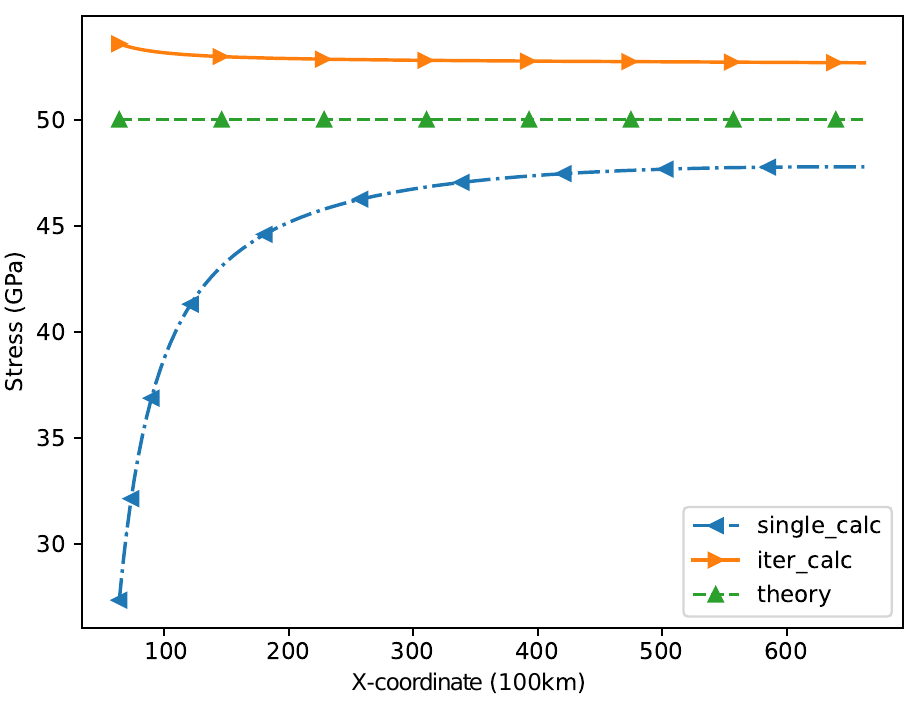
Figure 9. Stress distribution diagram of gradual section space elevator system by different methods.